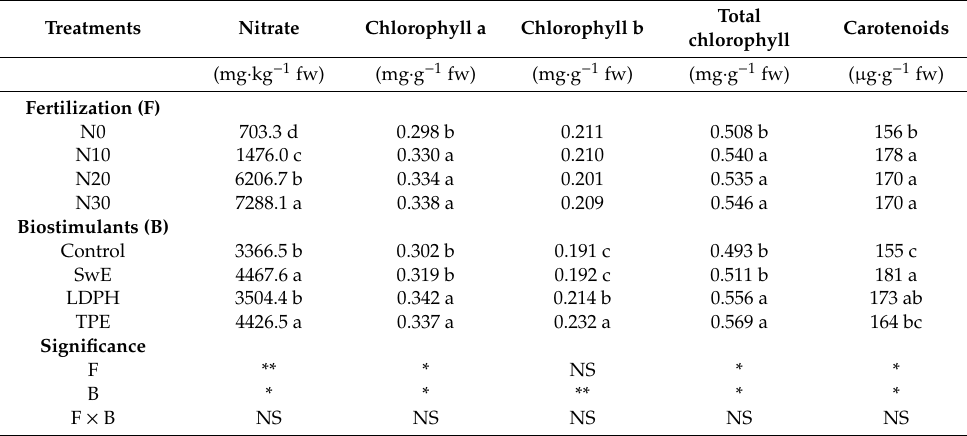
Table 4. E ff ects of nitrogen (N) fertilization levels (0, 10, 20 and 30 kg N · ha − 1 ; N0, N10, N20 and N30, respectively) and biostimulant applications (untreated control, SwE: Extract of seaweed Ecklonia maxima , LDPH: Legume-derived protein hydrolysate and TPE: Tropical plant extract) on nitrate, chlorophyll and carotenoids content of baby lettuce